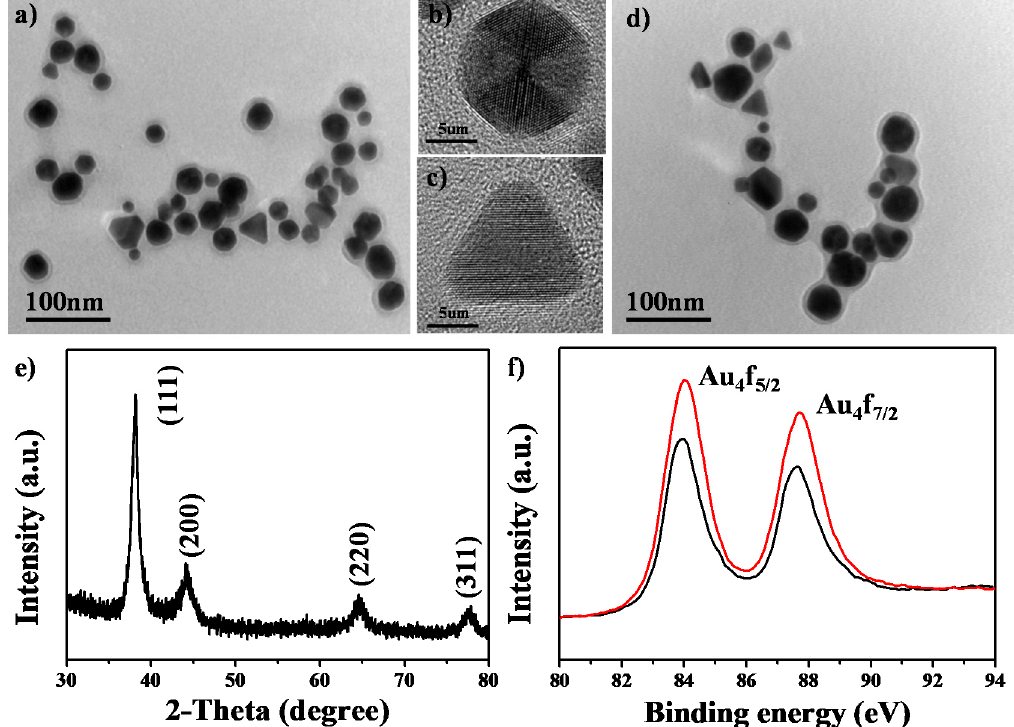
Figure 1. ( a ) Transmission electron microscopy (TEM) image and ( b , c ) High-resolution TEM (HR-TEM) images of Au@TNA nanoparticles (NPs). ( d ) TEM image of Au@TNA@MB NPs. ( e ) X-ray diffraction (XRD) pattern of Au@TNA@MB NPs. ( f ) X-ray photoelectron spectroscopy (XPS) gold (Au) 4f orbitals of Au@TNA (red) and Au@TNA@MB (black) NPs. Nanomaterials 2020 , 10 , x FOR PEER REVIEW